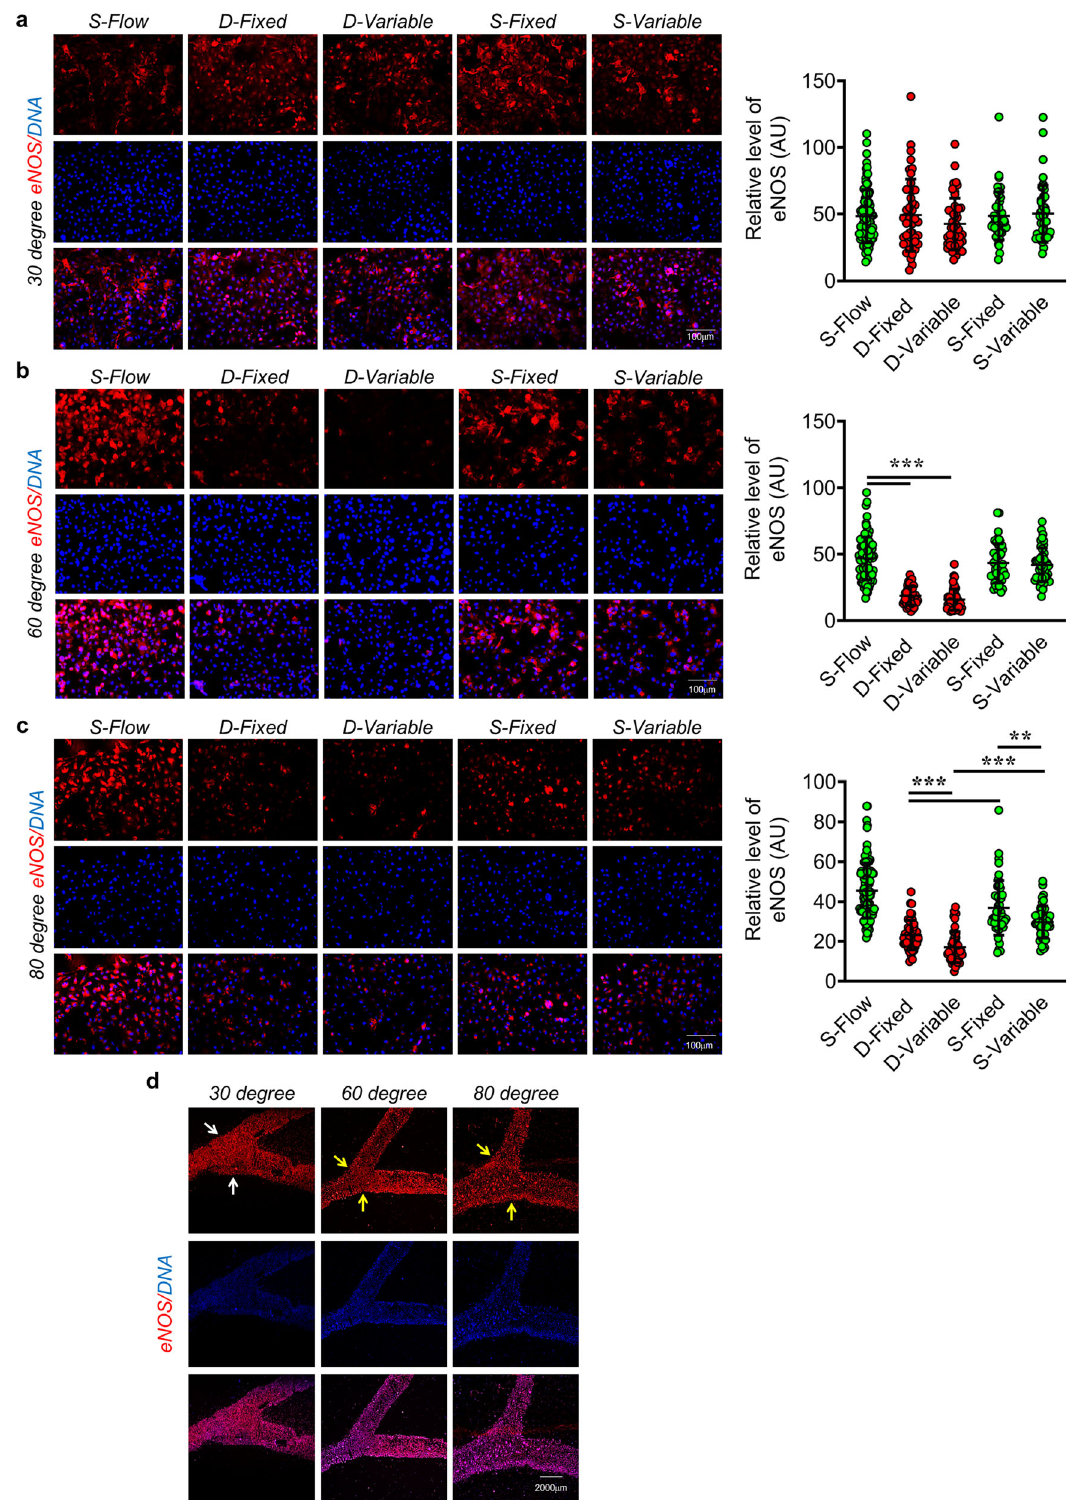
Fig. 3 Exposure of EC to D-Flow in microchannels with varying angles of bifurcation leads to reduced eNOS expressions. a – c Immuno fl uorescence staining of EA.hy926 for eNOS ( n = 3) after 4 h fl uid fl ow exposure, using human coronary microchannels with 30° ( a ), 60° ( b ) and 80° ( c ) branching points. DAPI staining is shown in blue. eNOS fl uorescence signal in individual EA.hy926 cells (dots) from three individual experiments. Fluorescence intensity AU values per individual cells are indicated together with the mean. Total number of cells, n ≥ 45. Values represent the mean ± SD. * p < 0.05, ** p < 0.01 and *** p < 0.001, by one-way ANOVA. Magni fi cation: ×20, Scale: 100 µ m. d Tile scan images microchannels harbouring EC stained for eNOS. Magni fi cation: ×10, Scale: 2000 µ